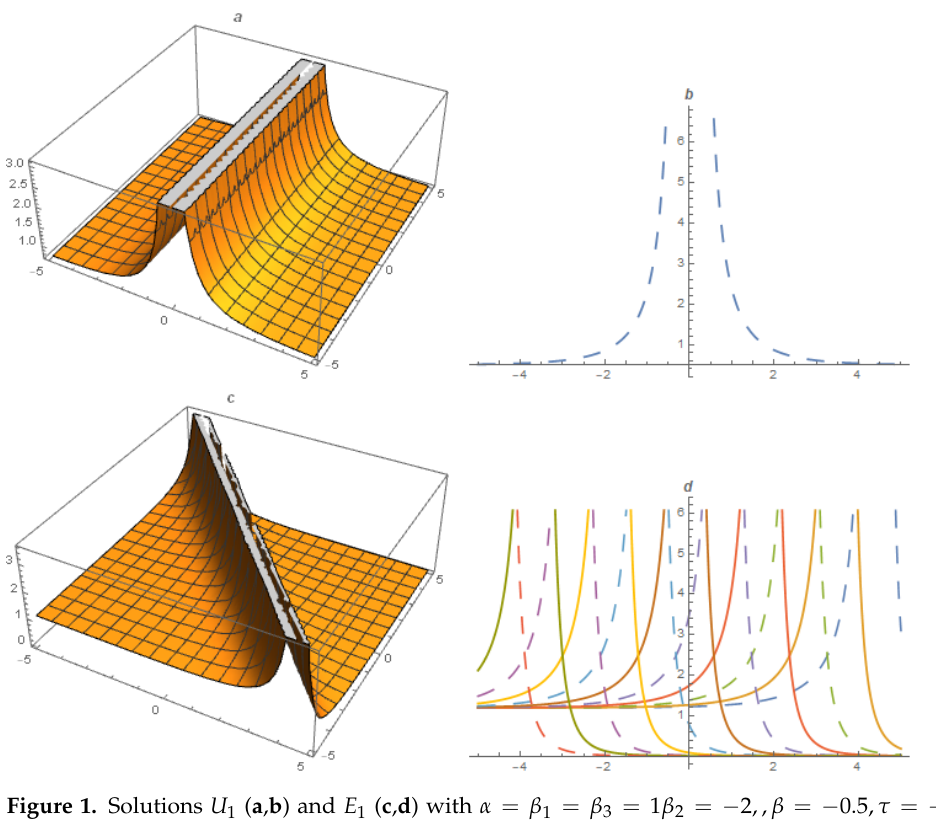
Figure 1. Solutions U 1 ( a , b ) and E 1 ( c , d ) with α = β 1 = β 3 = 1 β 2 = − 2,, β = − 0.5, τ = − 0.01, (cid:101) = − 1 and α = β 1 = β 3 = 1, β 2 = − 2, β = − 0.1, δ = 1.5, τ = − 0.01, (cid:101) = − 1,